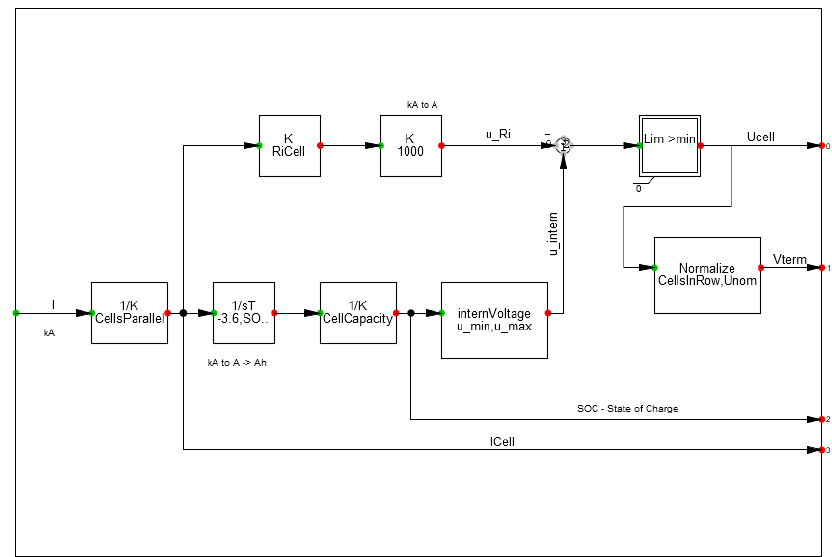
Figure 5. Common model of the battery.